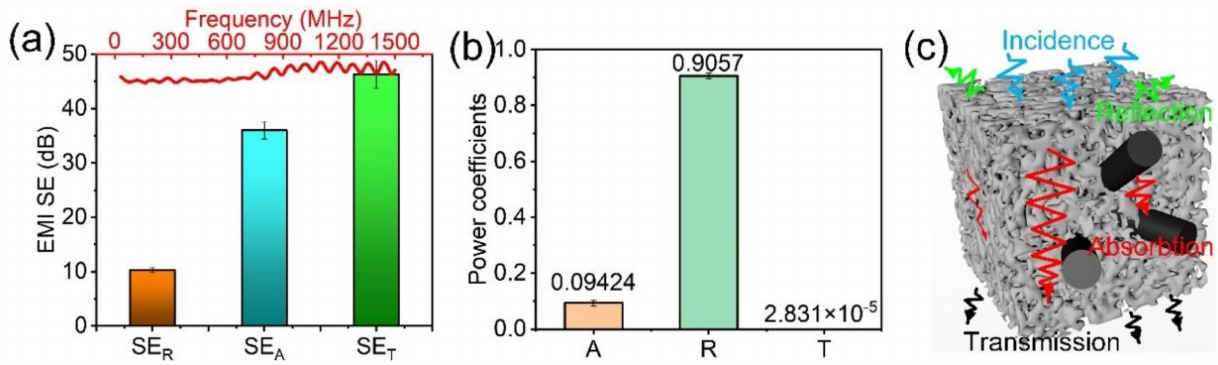
Figure 3. ( a ) EMI SE, ( b ) power coefficients, and ( c ) EMI shielding mechanism of the CFG